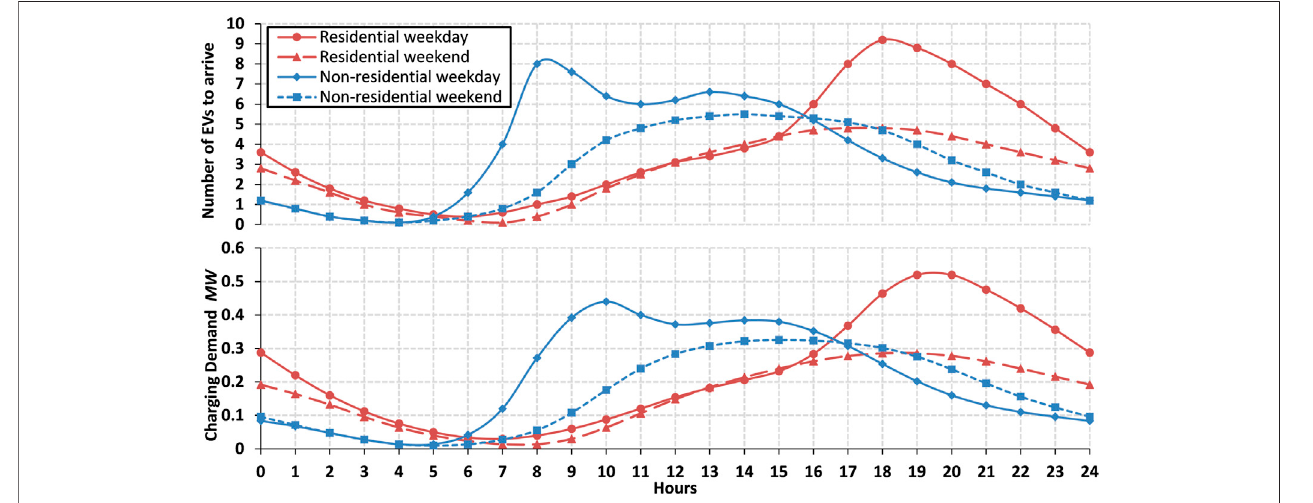
FIGURE 2 | EV arrival pattern and average charging power demand